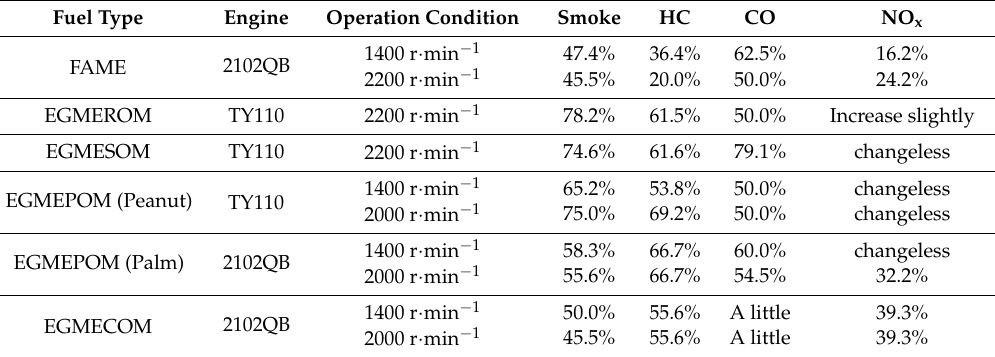
Table 3. Effect of biodiesel on the reduction of engine emissions